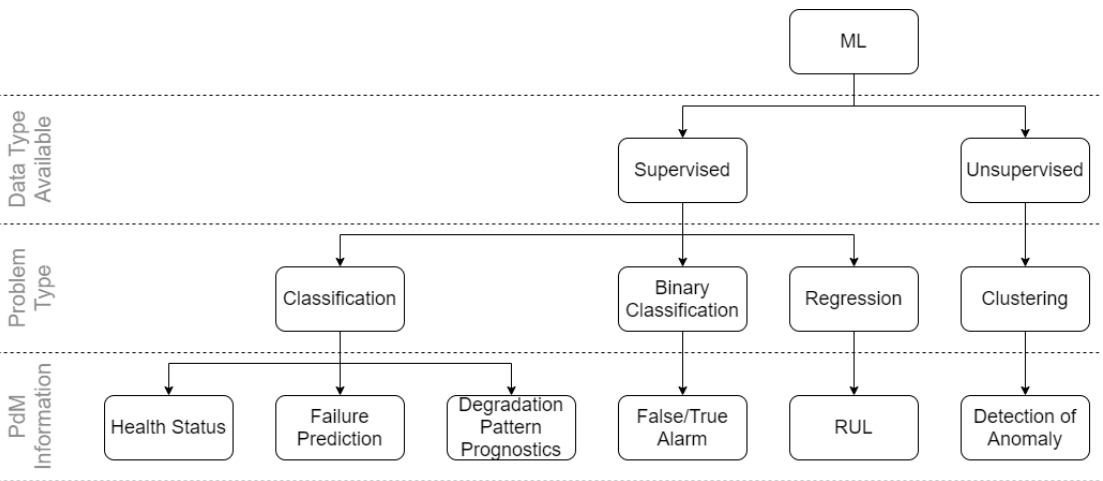
Figure 3. An overview of various methods that can be chosen depending on what information is desired and to what extent data is